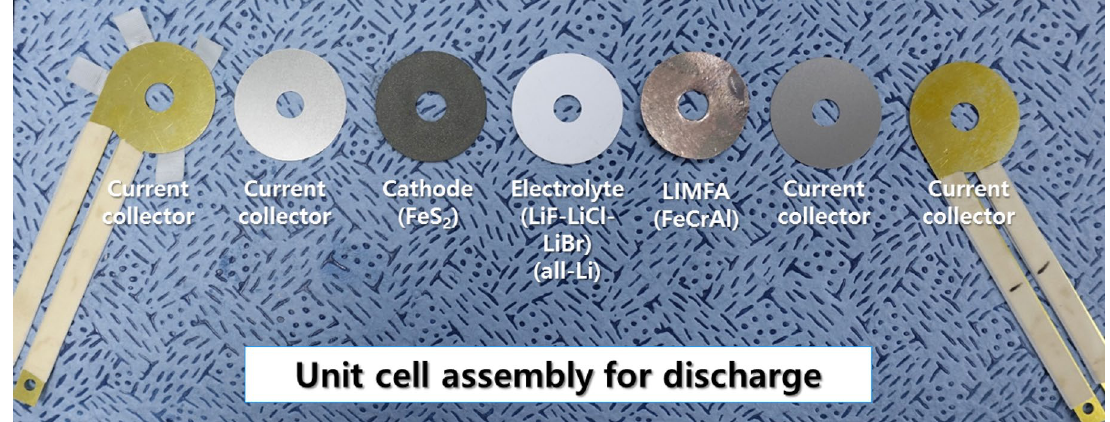
Figure 2. Components of a LIMFA FeCrAl unit cell. For evaluating Li(Si) unit cell discharge, LIMFA (FeCrAl) is replaced with a Li(Si)